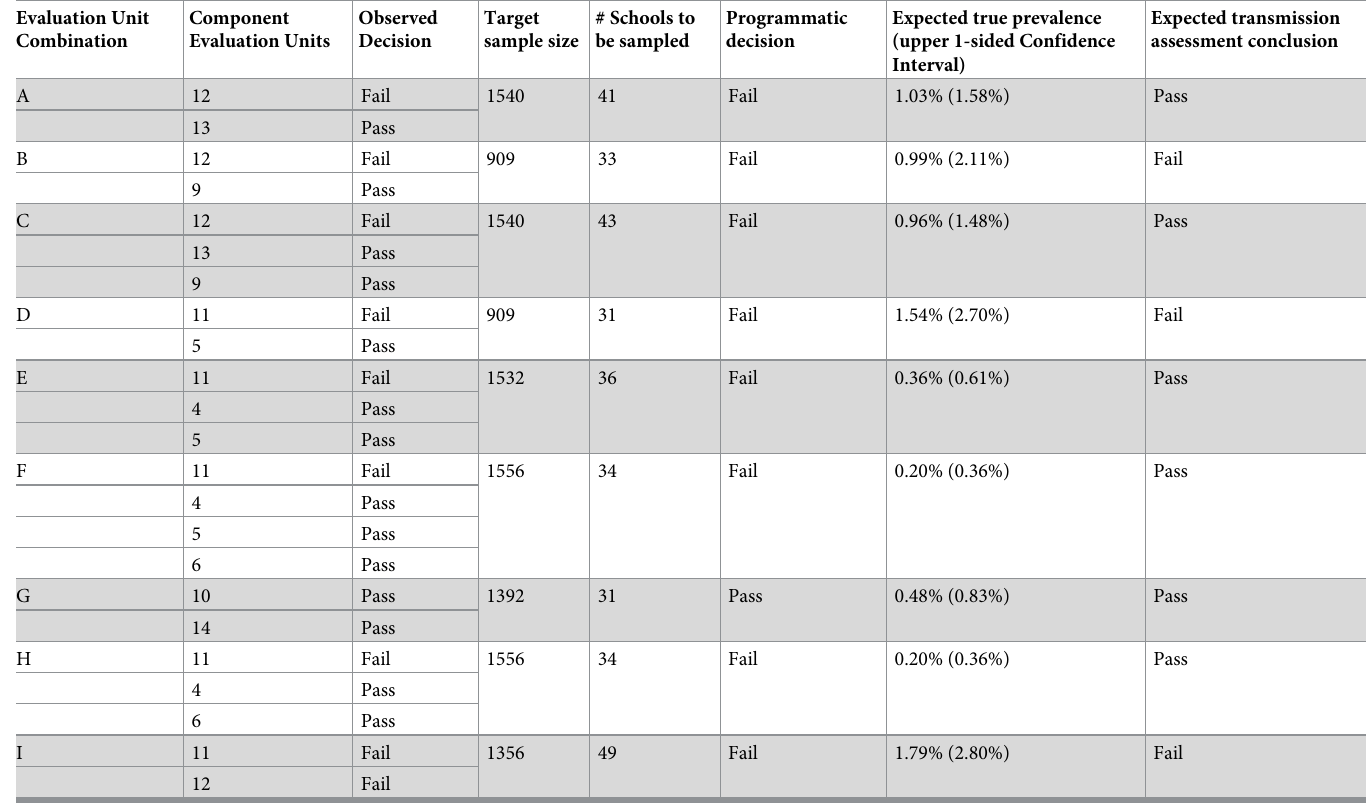
Table 2. Characteristics of combination Evaluation Units, formed from adjoining Evaluation